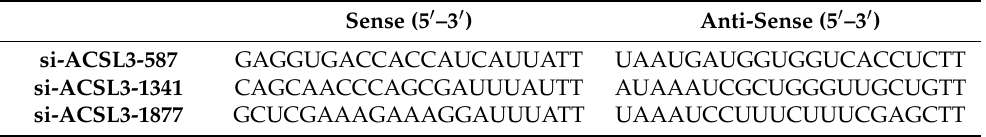
Table 1. ACSL3 siRNAs.